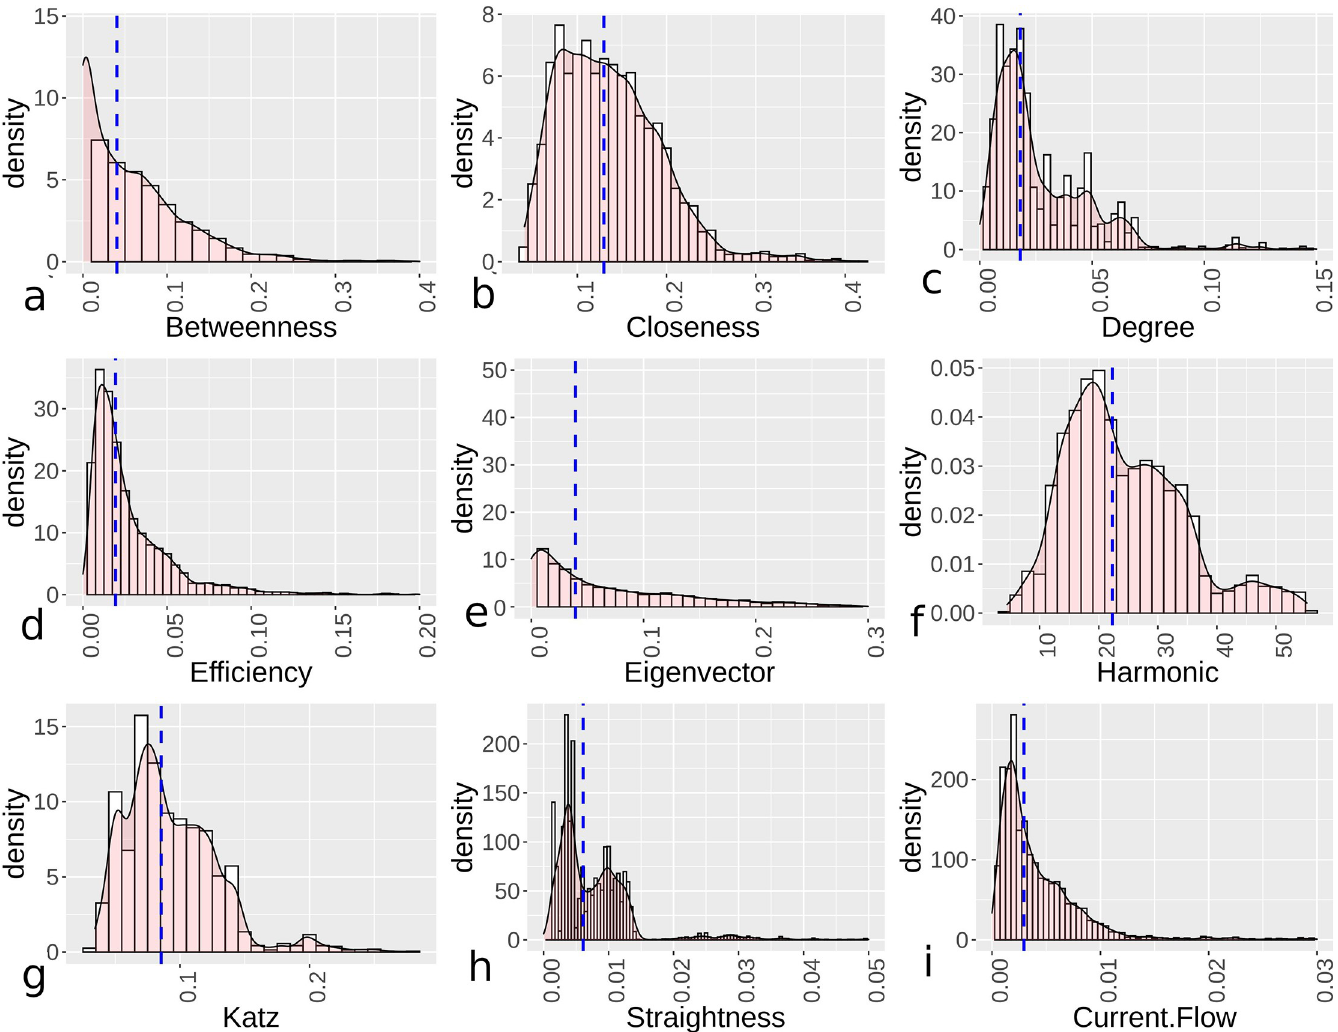
Fig 4. Kernel density plots showing centrality distributions for orthogonal settlements’ centrality values with the dashed lines showing median values. Graphs depict betweenness (a), closeness (b), degree (c), efficiency (d), eigenvector (e), harmonic (f), Katz (g), straightness (h), and current flow